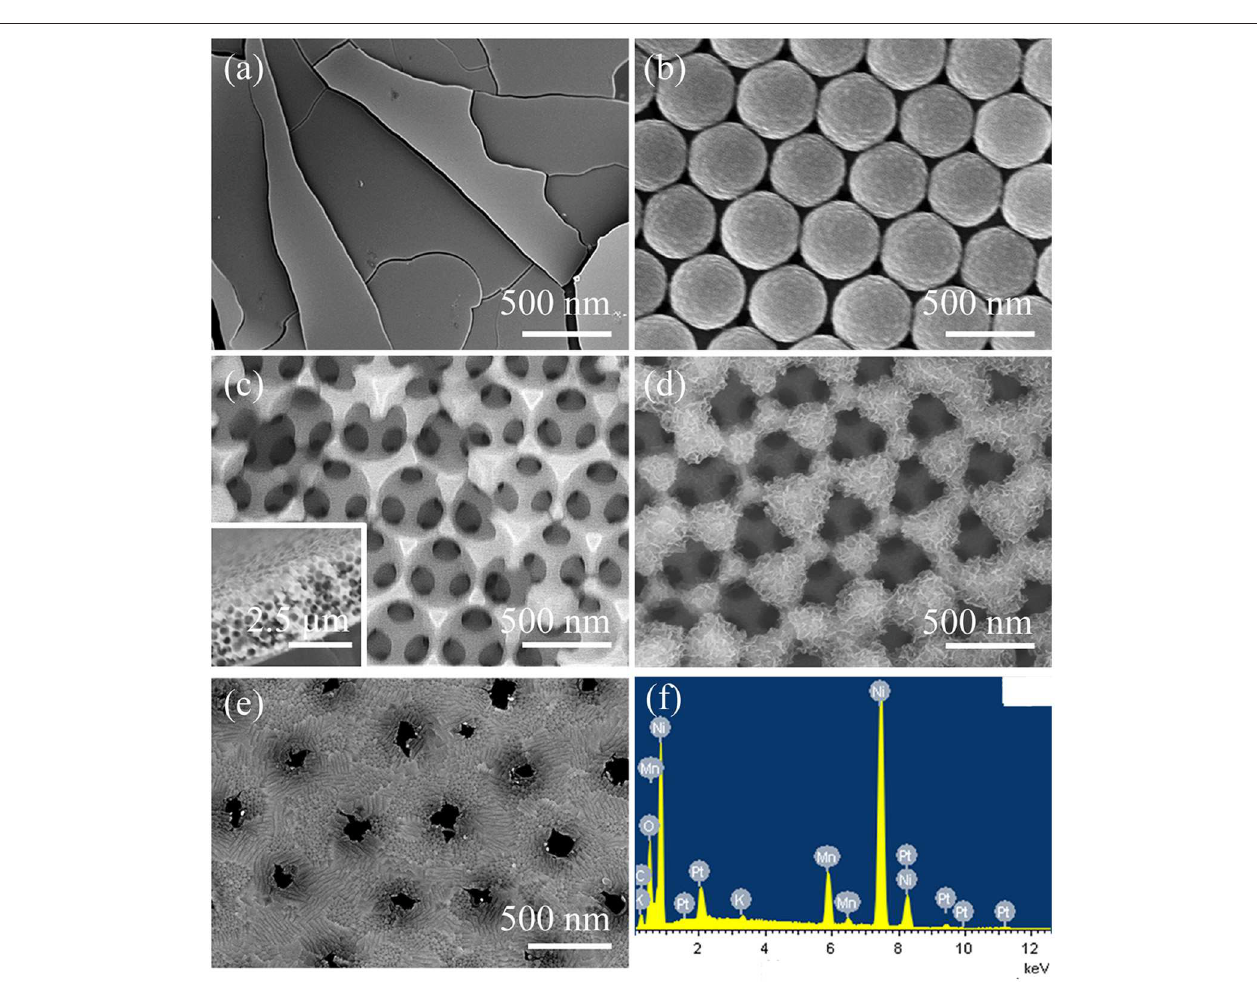
FIGURE 1 | SEM images of (a) MnO 2 @Ni foil, (b) PS opal template on the ITO substrate and (c) Ni-pc with the PS opal template annealed at 104 ◦ C and Ni electrodeposition for 1h. Inset is the sectional view of Ni-pc; SEM images of (d) the obverse side and (e) the back side of MnO 2 @Ni-pc (electrodeposition MnO 2 for 300 segments); (f) EDX spectrum of MnO 2 @Ni-pc.